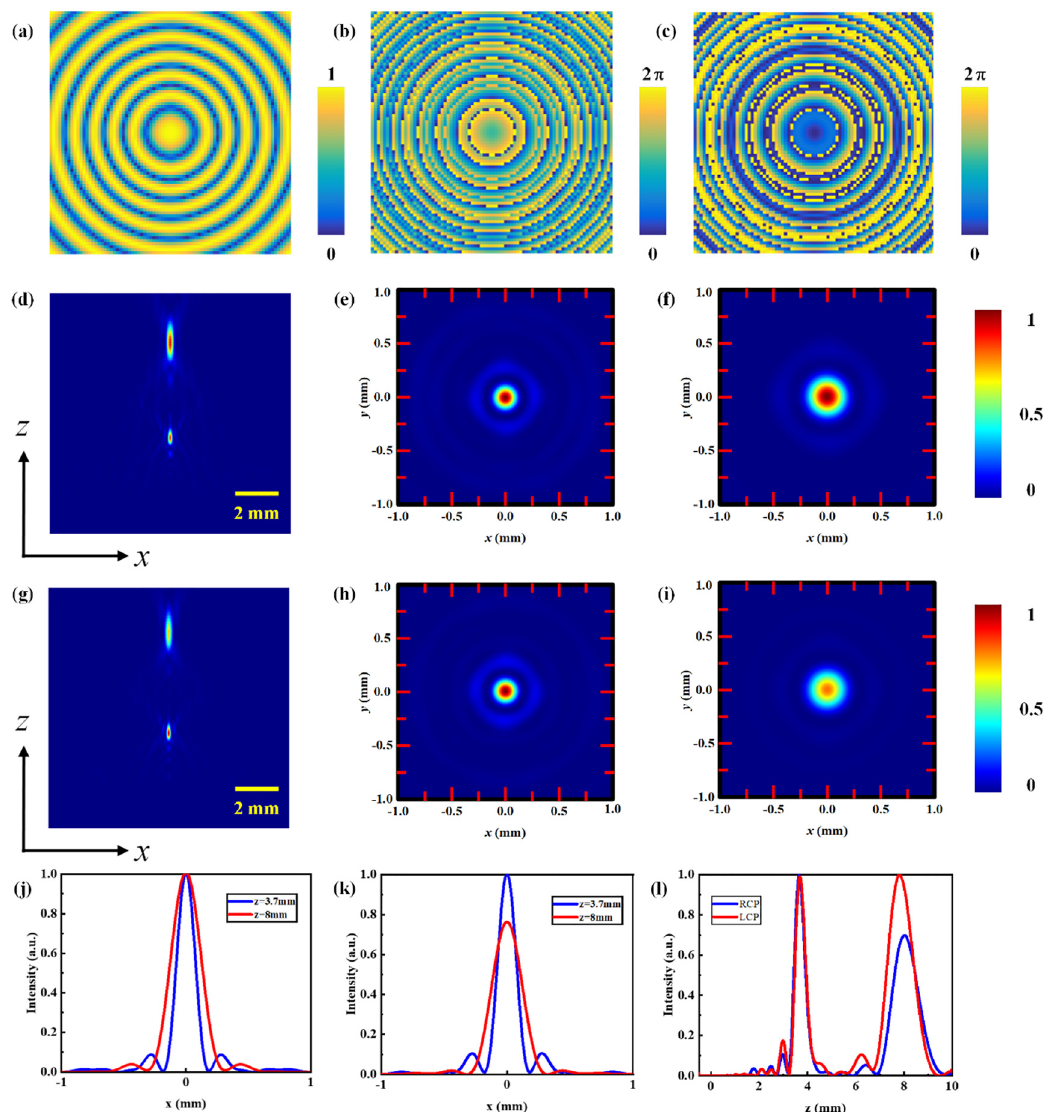
Figure 3: Design and characterization of the axial bifocal metalens. (a) The required amplitude distribution of the target field. (b) The required phase distribution of the target field. (c) The coded phase distribution.(d – f) The transmitted fieldprofilesundertheLCP illumination: (d) The axial intensity profile.(e)The simulatedintensity profileof the first focal plane f 1 . (f) The simulated intensity pro fi le of the second focal plane f 2 . (g – i) The transmitted fi eld pro fi les under the RCP illumination: (g)The axial intensity pro fi le. (h) The simulatedintensity pro fi le of the fi rst focalplane f 1 . (i) The simulatedintensity pro fi le of the second focal plane f 2 . (j) The intensity pro fi les across the two focal planes under the LCP illumination. (k) The intensity pro fi les across the two focal planes under the RCP illumination. (l) The comparison of intensity pro fi les along the optical axis under the LCP/RCP